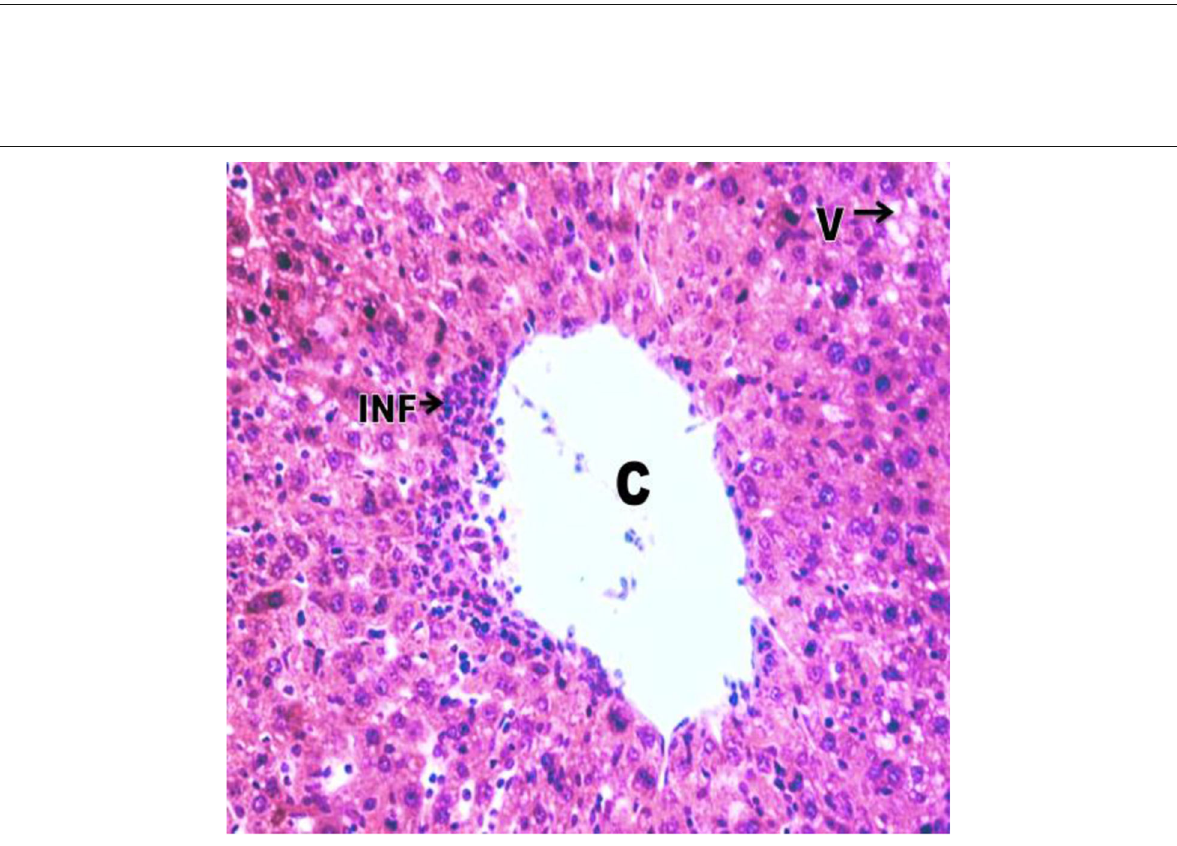
Fig. 2 Photomicrograph of a section of the liver of control mouse, showing a portal area containing a branch of the hepatic portal vein (HPV), hepatic artery (HA), and bile ductule (B). (H&E, ×